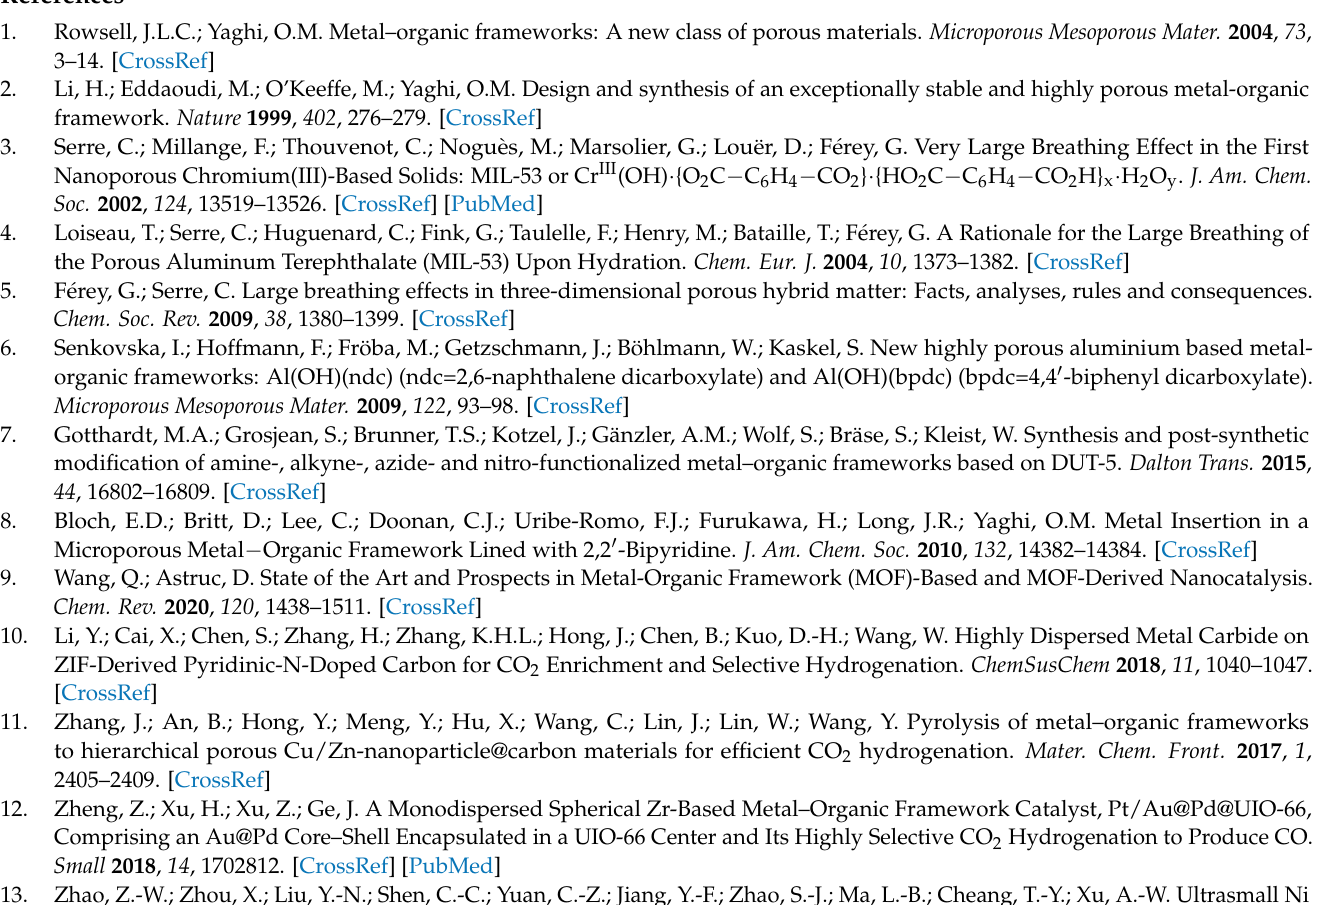
LMnCl(HCO 2 )(H 2 ) complex; Figure S4: the identified vibrational modes of LMnCl(COOH) minimum structures; Figure S5: the calculated energetics along H–H interatomic distance of LPdCl(HCO 2 )(H 2 ) and LPtCl(HCO 2 )(H 2 ) complexes; Figure S6: the H 2 activation profiles of MCl(HCO 2 ), M = V, Zn, Cd, and Hg complexes; Table S1: various MCl 2 , M = Pd and Sc, formation energetics in MOF-253; Table S2: calculated structural information of MOF-253 upon PdCl 2 coordination; Table S3: the labels of the spin states of LMCl 2 (H 2 ) intermediates; Table S4: the H-H bond lengths of the optimized 6- coordinated LMCl 2 (H) 2 intermediates; Table S5: the H-H bond lengths of the optimized 5-coordinated LMCl(H) 2